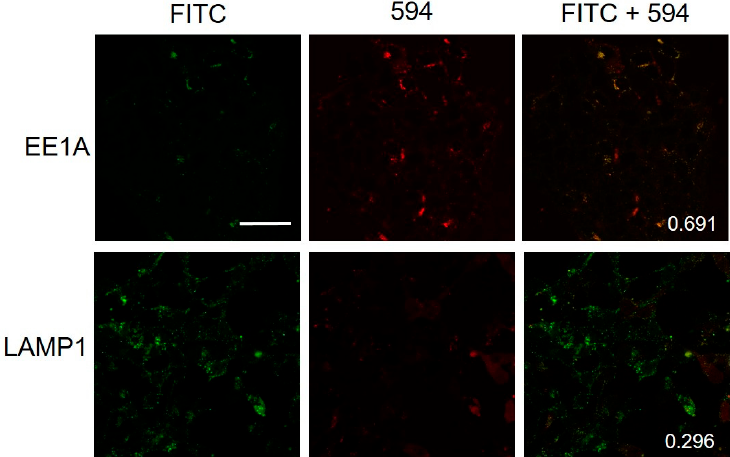
Figure 5. Confocal microscopy images of FaDu cells incubated for 20 min with FL8V1 (10 µ M) at 37 ◦ C and EE1A/Alexa Fluor 594 or LAMP1/Alexa Fluor 594; bar represents 50 µ m; number indicates Pearson’s correlation coefficient.